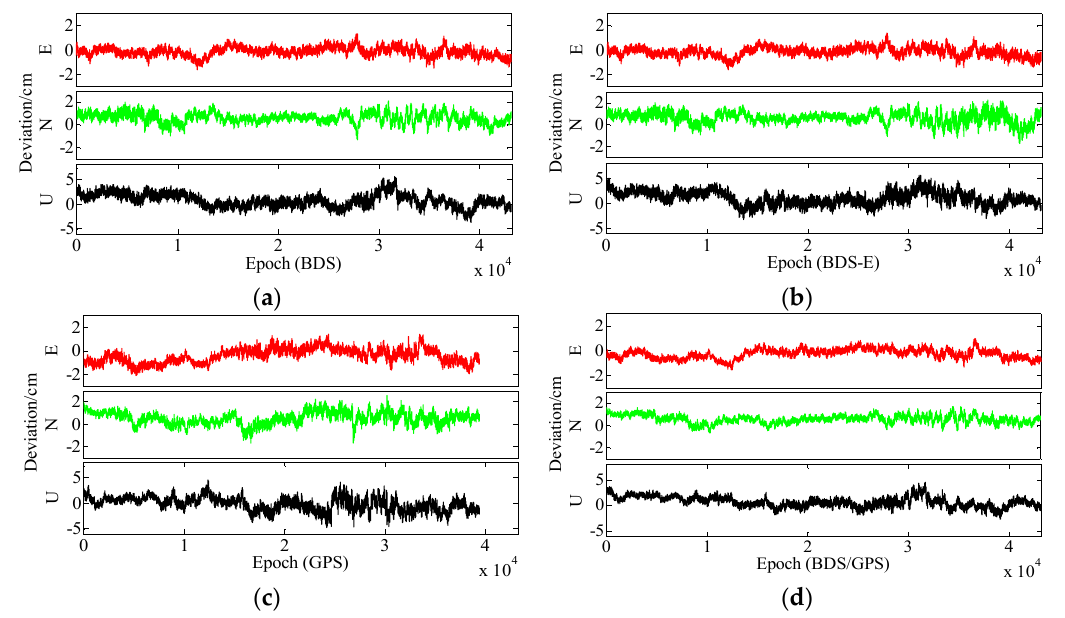
Figure 10. ENU deviations of four systems for group B. ( a ) ENU deviations of BDS for group B. ( b ) ENU deviations of BDS-E for group B. ( c ) ENU deviations of GPS for group B. (d ) ENU deviations of BDS/GPS for group B.